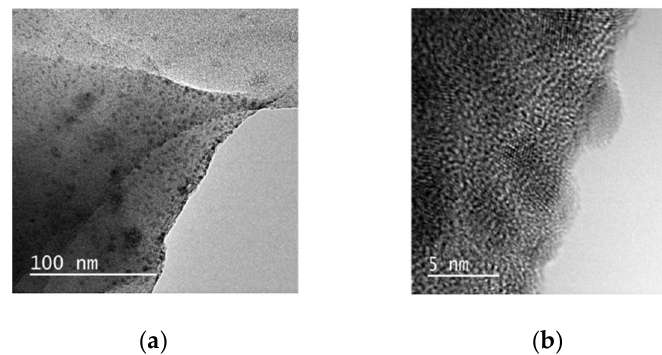
Figure 6. HR-TEM images of (TBA) 2 Mo 6 I i8 @GO at 100 ( a ) and 5 nm ( b ) scale, registered at 200 kV.